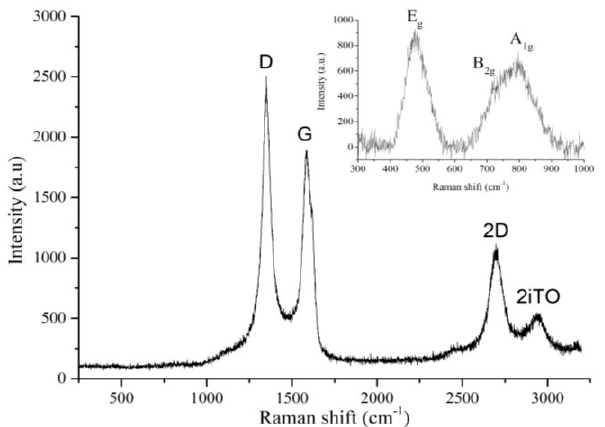
Figure 2. Raman spectra of MWCNTs with a zoom in the 300–1000 cm − 1 region (in the inset) corresponding to iridium oxide